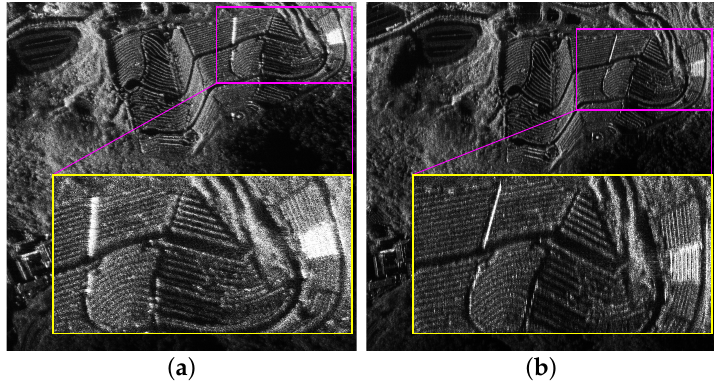
Figure 18. Comparison between TFST and DST. ( a ) DST and ( b ) TFST.